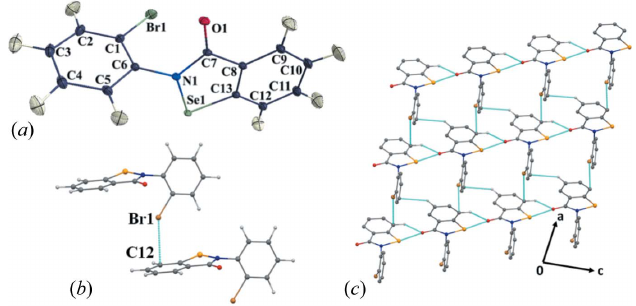
Figure 3 ( a ) An ORTEP view of (cid:4) -Se, drawn with 50% probability displacement ellipsoids at 100 K. Ring Cg 1: C1–C6; ring Cg 2: C8–C13. ( b ) The molecular pair formed by the Br (cid:2)(cid:2)(cid:2) (cid:3) interaction. ( c ) A view of the molecular packing, down the ac plane.